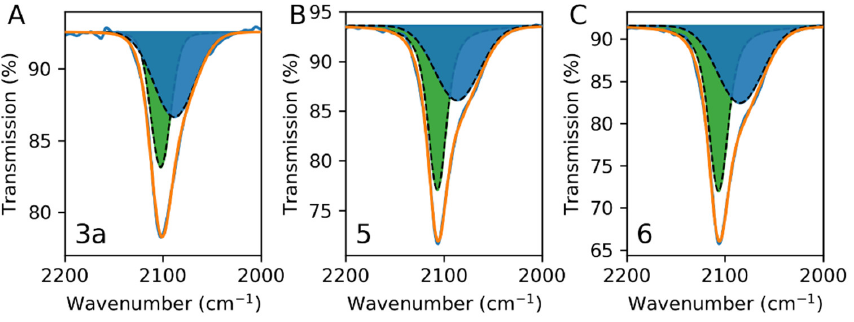
Figure 6. ATR-IR spectra in the 2000–2200 cm −1 window for samples 3a ( A ), 5 ( B ), and 6 ( C ).